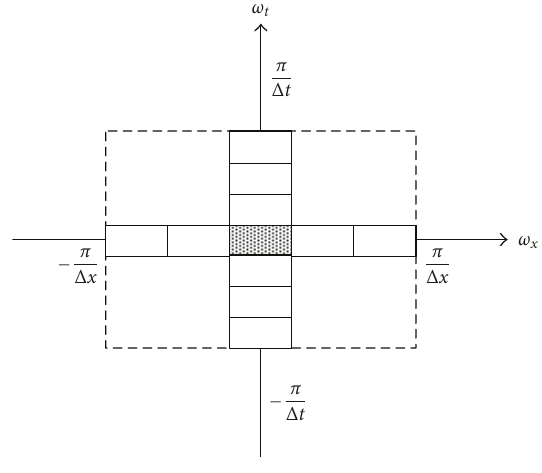
Figure 9: The spectrum covering set S